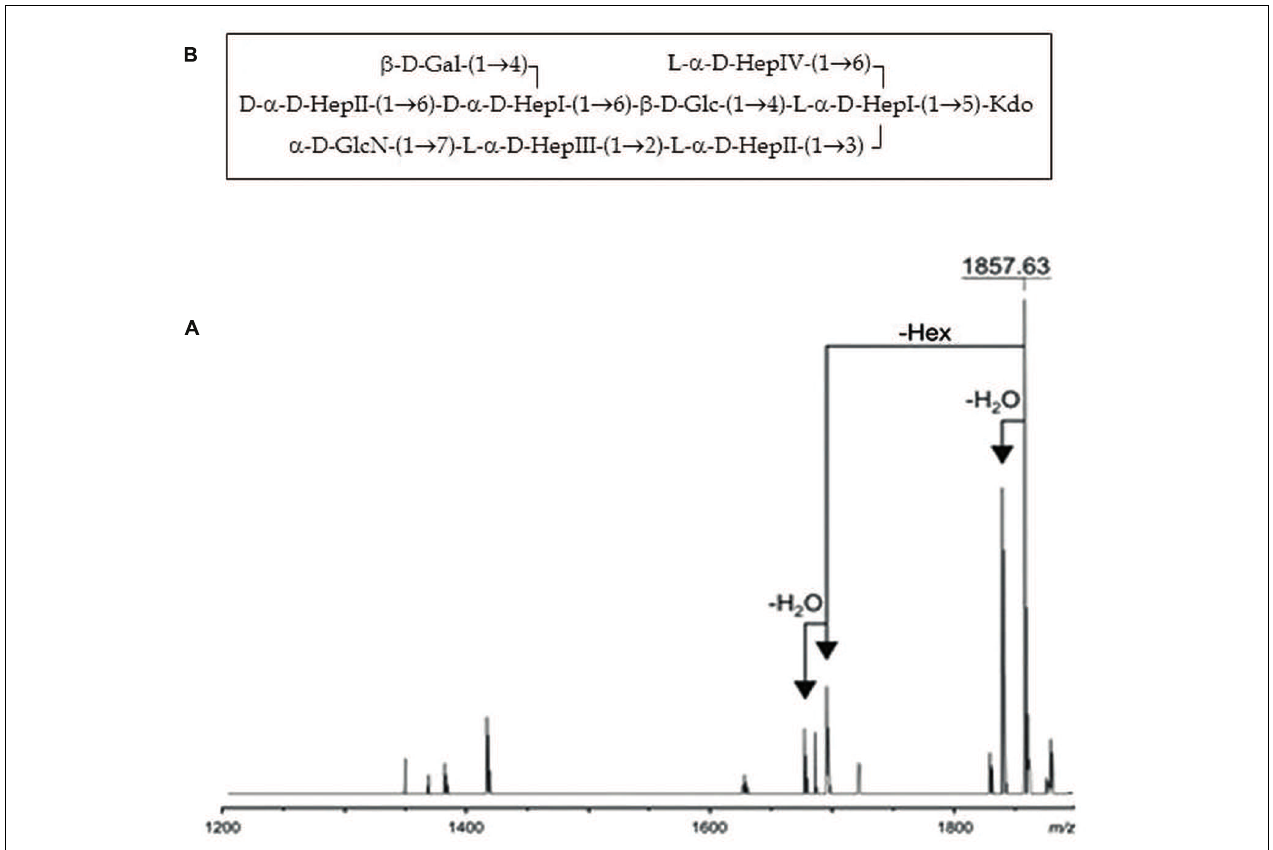
FIGURE 6 | (A) Positive-ion MALDI-TOF of purified LPS core from A. salmonicida subspecies pectinolytica strain CECT5752T. (B) Presumptive LPS-core structure of the same strain.